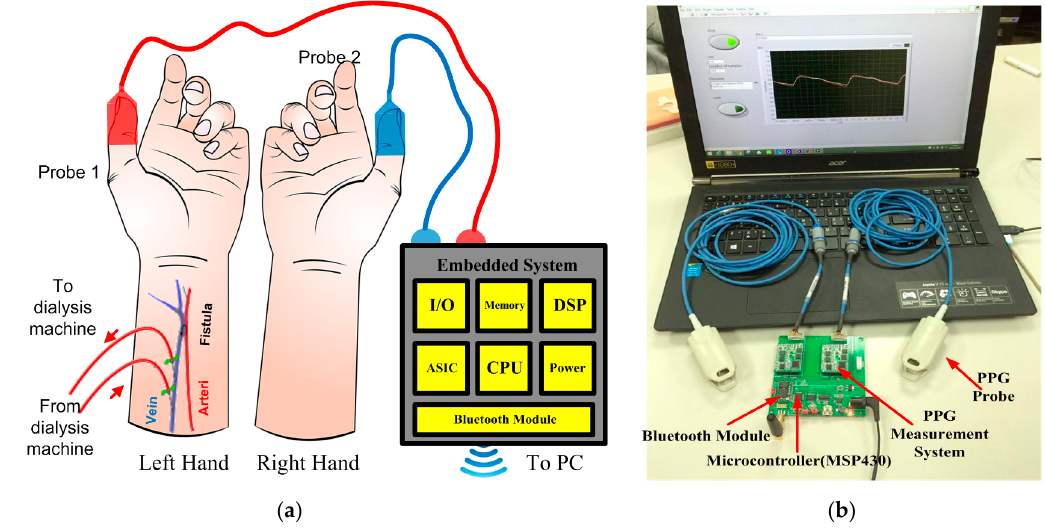
Figure1. Monitoring and recording system: ( a ) PPG probes placement; and ( b ) embedded system connected to a laptop computer.